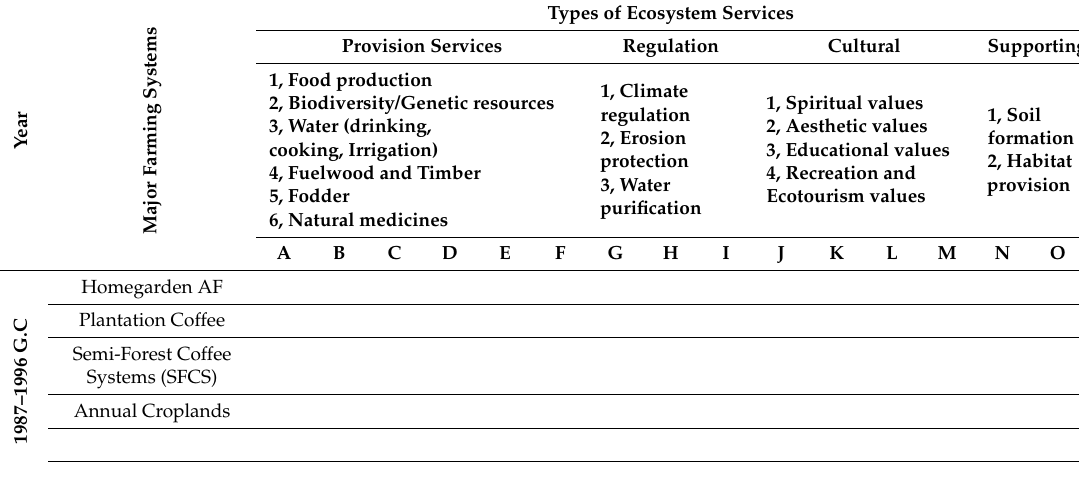
Table A1. Which of the following land-use/land-cover types do you practice or own and which are the associated benefits you utilized from each farming system type and each time period. Please indicate the importance through the numbers 1 = very important, 2 = important, 3 = medium, 4 = do not know, 0 = not